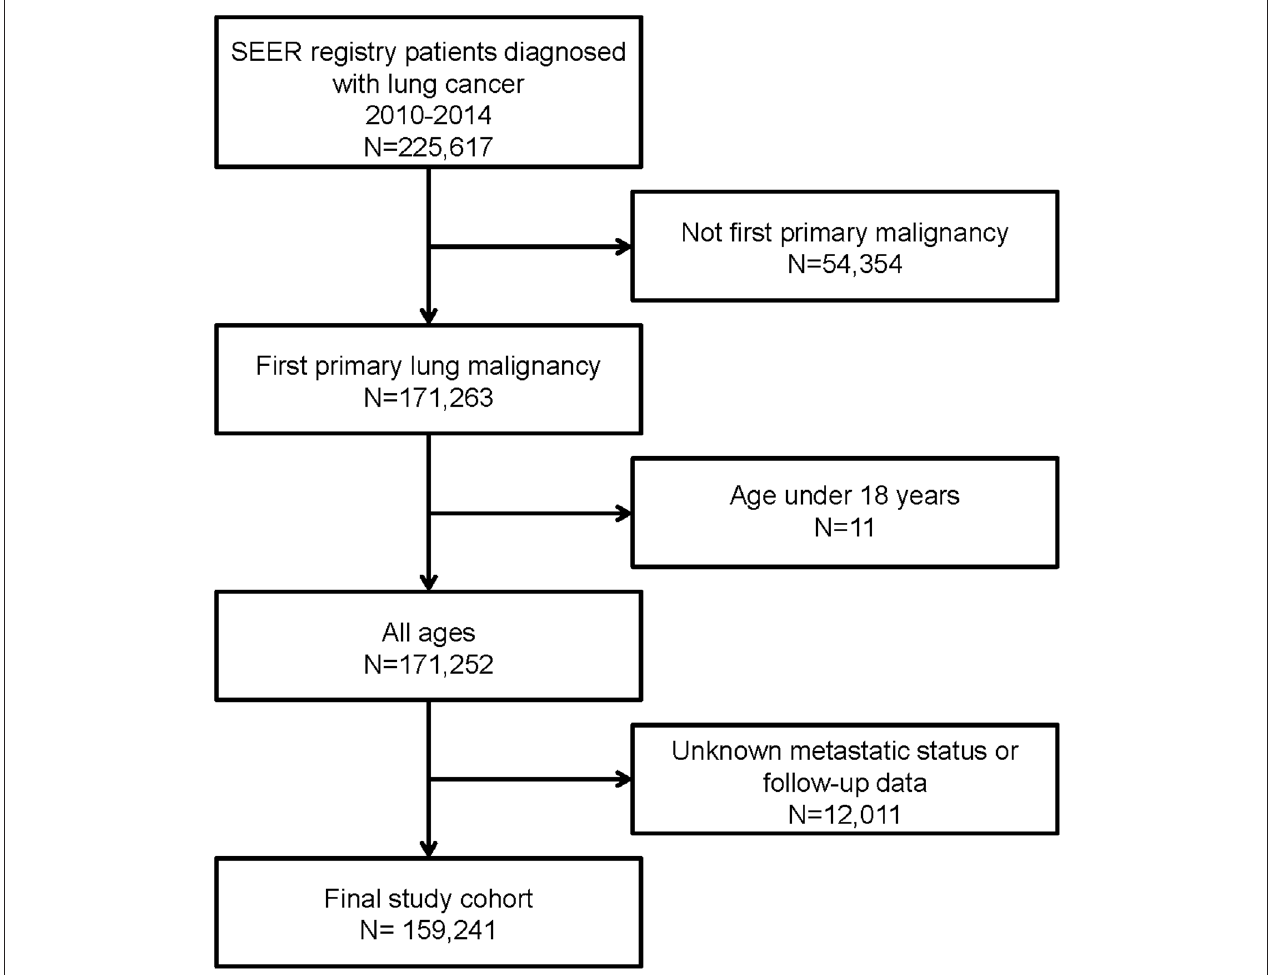
FIGURE 1 | Flowchart of patient selection in this